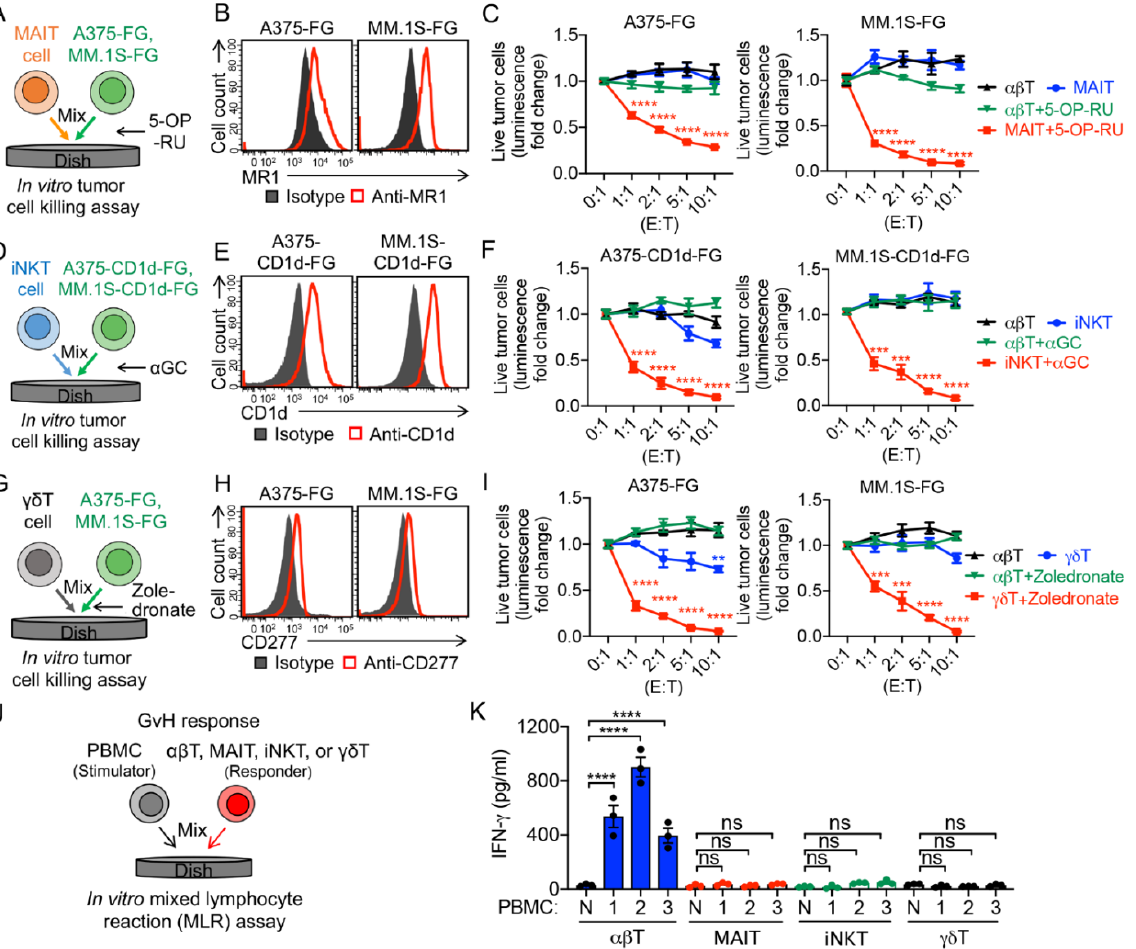
Figure 2. In vitro antitumor tumor efficacy and safety study of PBMC-derived T cells. ( A – C ) In vitro killing of human A375 melanoma and MM.1S multiple myeloma cells by MAIT cells. Both tumor cell lines were engineered to express firefly luciferase and green florescence protein (FG) dual reporters. ( A ) Experimental design. ( B ) FACS detection of MR1 on A375-FG and MM.1S-FG cells. ( C ) Tumor killing data at 24 h (n = 4). ( D – F ) In vitro killing of A375 and MM.1S cells by iNKT